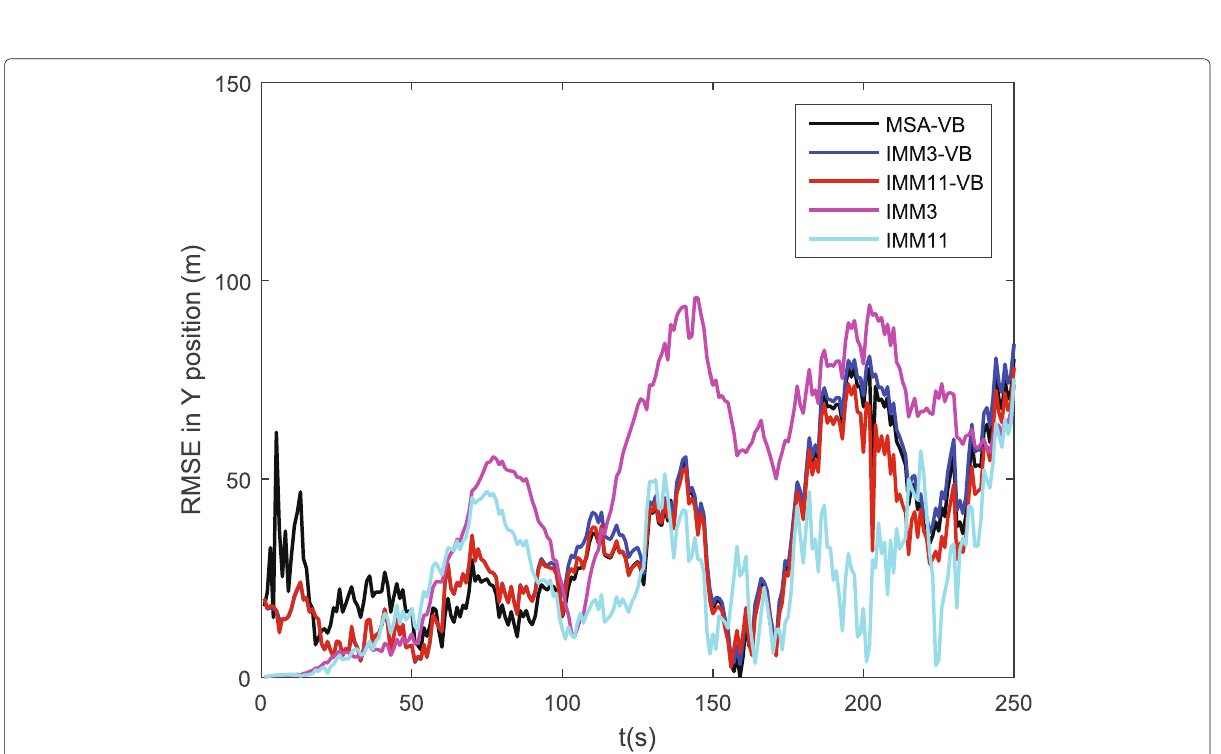
Fig. 2 RMSEs in Y position of the proposed algorithm, IMM3, IMM11, IMM3-VB, and IMM11-VB in scenario